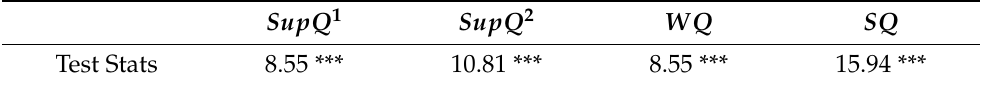
Table 4. Qu’s Cointegration Order Change Tests.